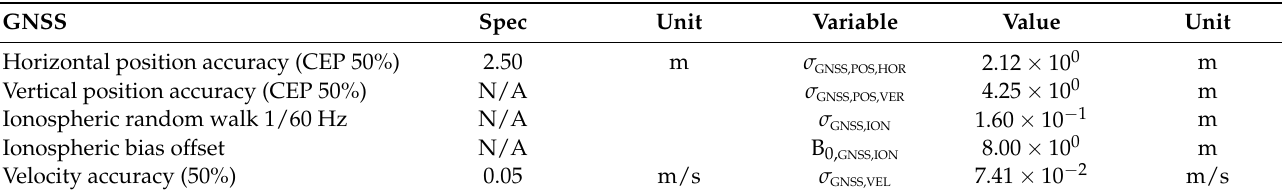
Table 17. Example of GNSS receiver performance values.